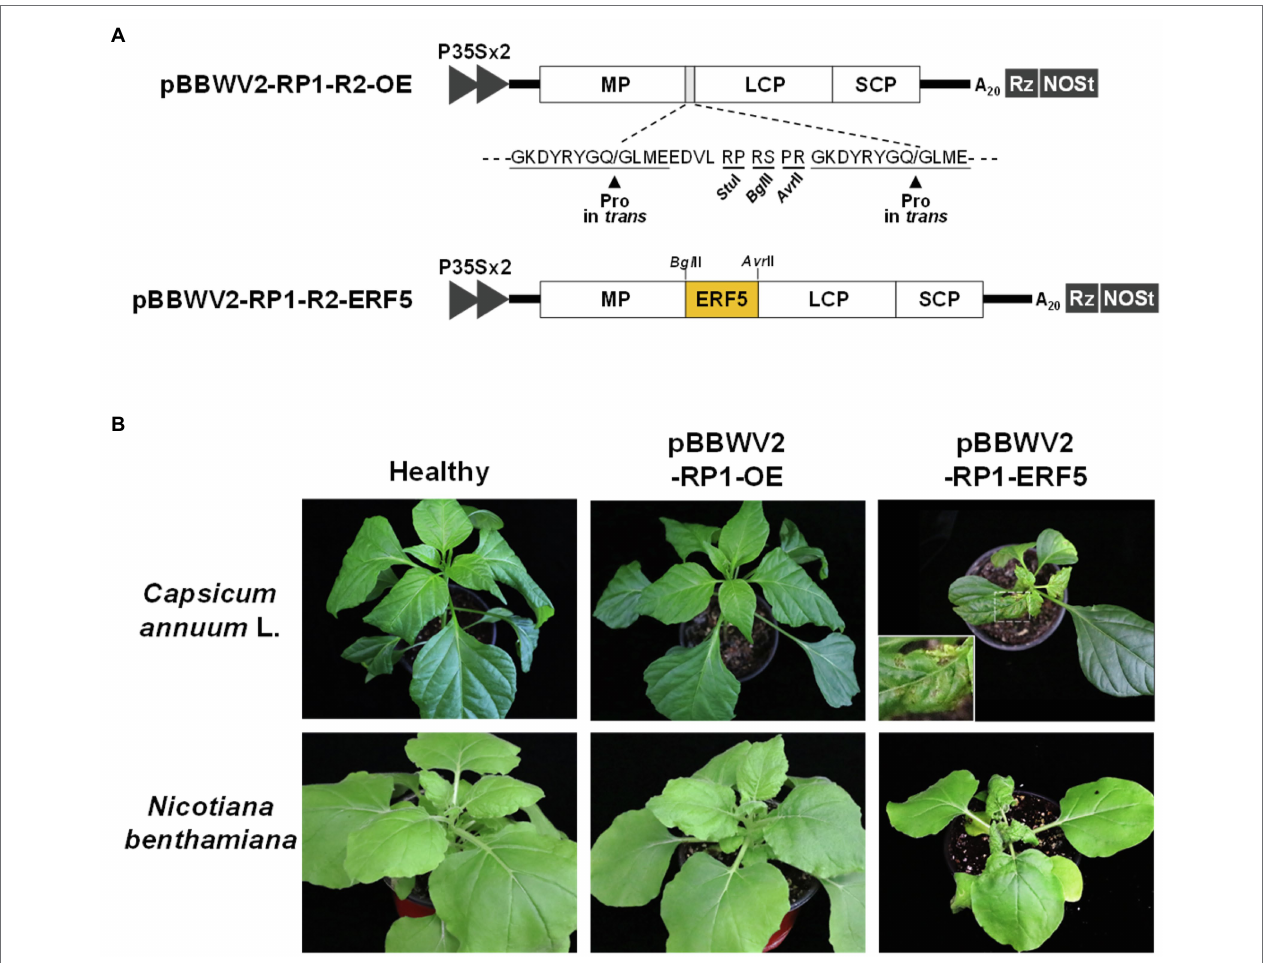
FIGURE 6 | Overexpression of ethylene responsive factor 5 ( ERF5 ) enhances symptom severity in pepper infected with the BBWV2 mild strain RP1. (A) Schematic representation of the BBWV2-RP1 RNA2 recombinant constructs. The ERF5 gene was inserted between movement protein (MP) and large coat protein (LCP) to be expressed by proteolysis when the virus replicates. In vivo transcription of the BBWV2-RP1 RNA2 recombinant constructs is under the control of a double 35S promoter (P35SX2), a cis-cleaving ribozyme sequence (Rz), and a NOS terminator (NOSt). (B) Symptomatic responses in pepper and N. benthamiana plants upon infection with pBBWV2-RP1-ERF5. The inocula are indicated above each image. An enlargement of the boxed area is shown in the upper right